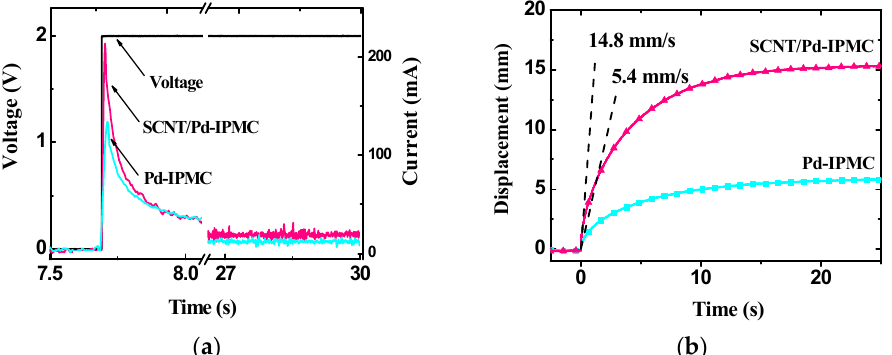
Figure 7. Electromechanical behaviors of the IPMCs. ( a ) Actuation current curves; ( b ) displacement curves under 2 V DC voltage in 25 s.